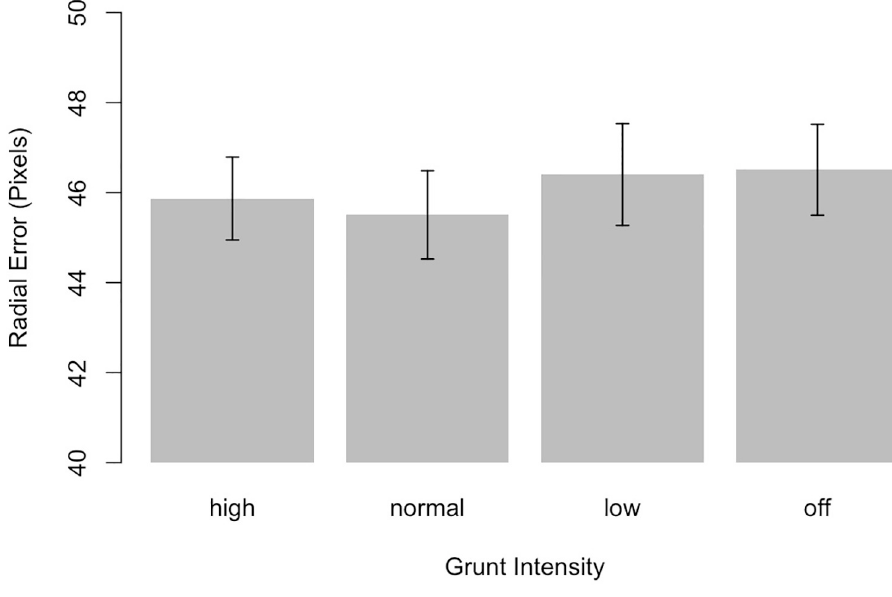
Fig 4. The influence of grunt intensity on radial error of the ball’s landing position. Error bars indicate 95% confidence